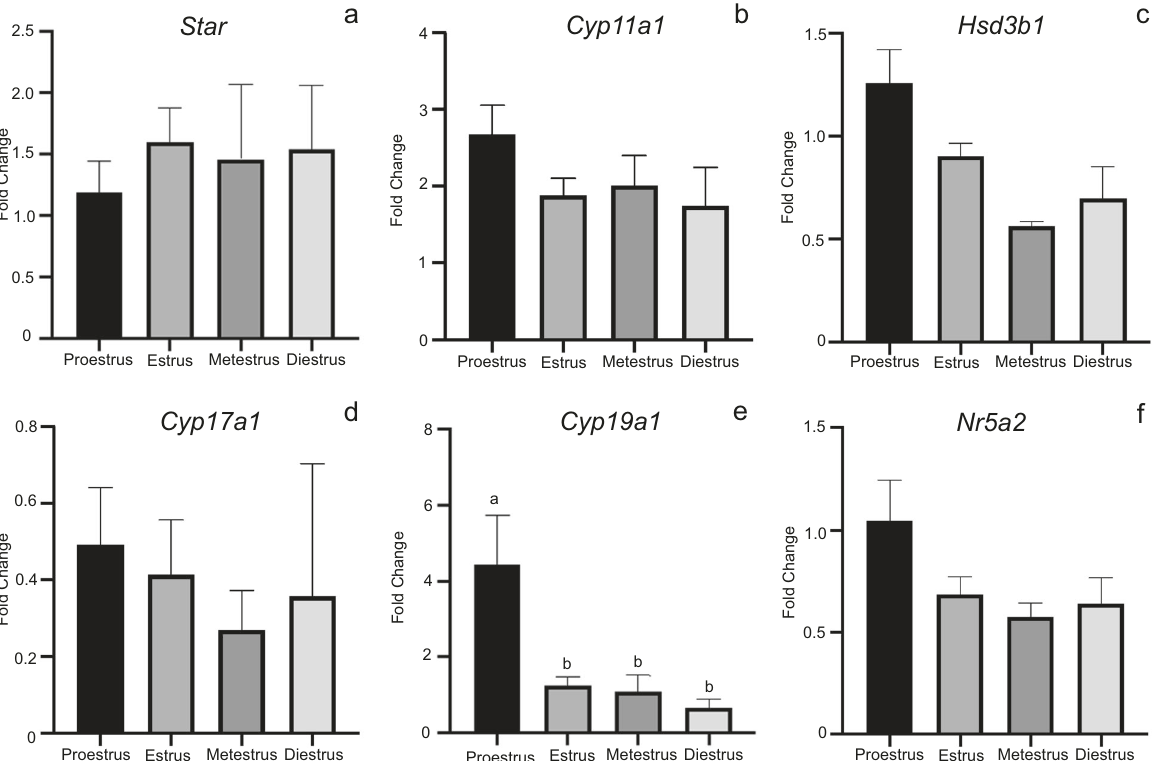
Fig. 5 Whole ovarian tissue steroidogenic gene expression by stage of estrous cycle. Histograms depict relative fold change ( ΔΔ Ct method) for a Star , b Cyp11a1 , c Hsd3b1 , d Cyp17a1 , e Cyp19a1 , and f Nr5a2 following normalization to 18S; n = 8 – 10/treatment group; 10BL, 10VC, 8HC, 10FL). a,b Means ± SEM with different superscripts are signi fi cantly different ( p ≤